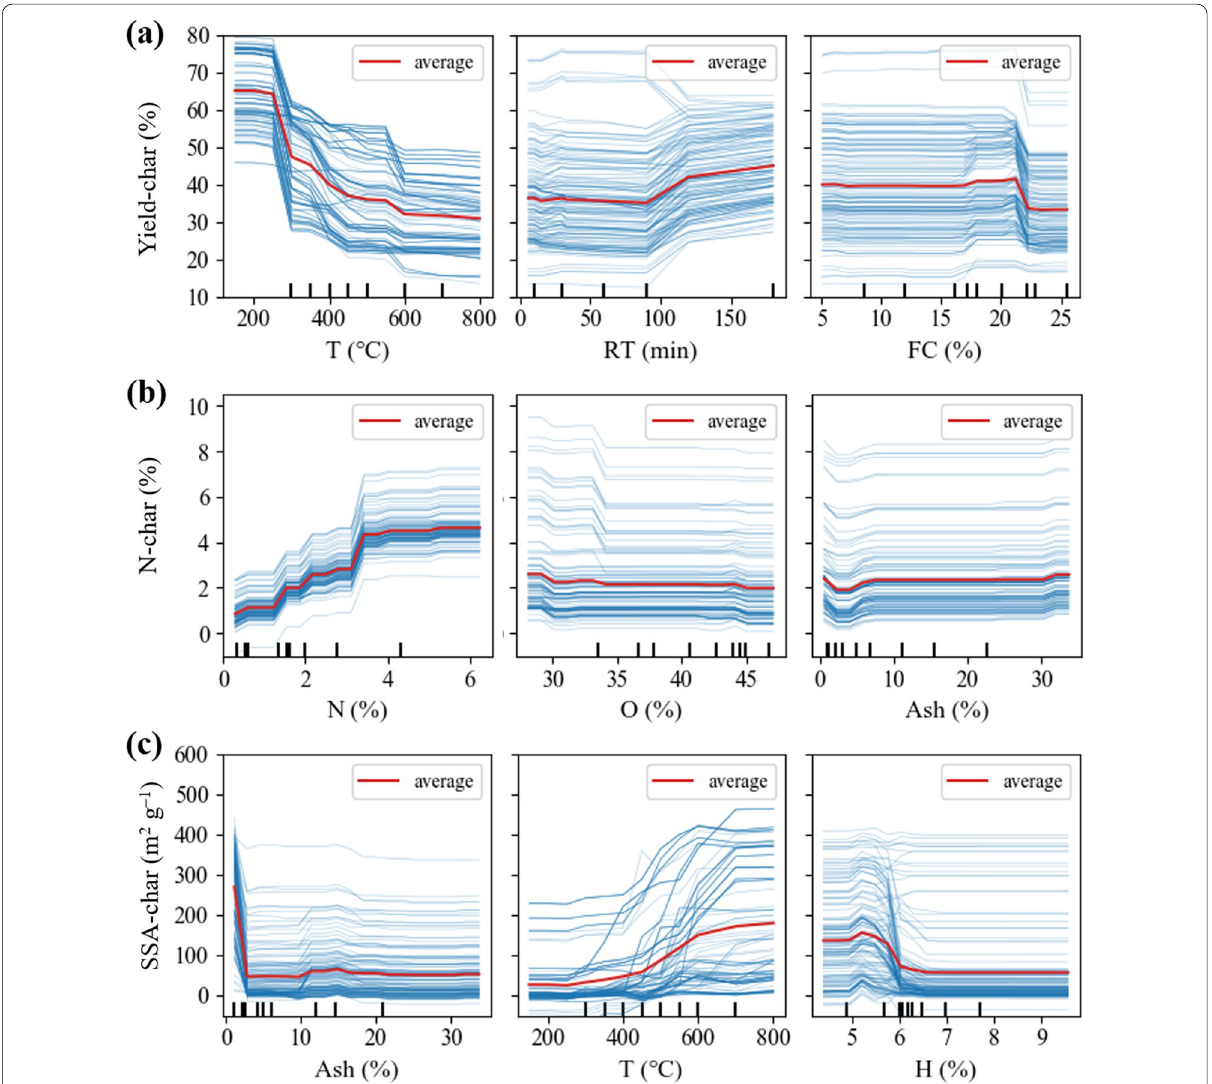
Fig. 6 Partial dependence plots of the top-three inputs to the prediction of a Yield-char b N-char, and c SSA-char based on improved GBR model developed from dataset #1_5, #2_5, #3_5,